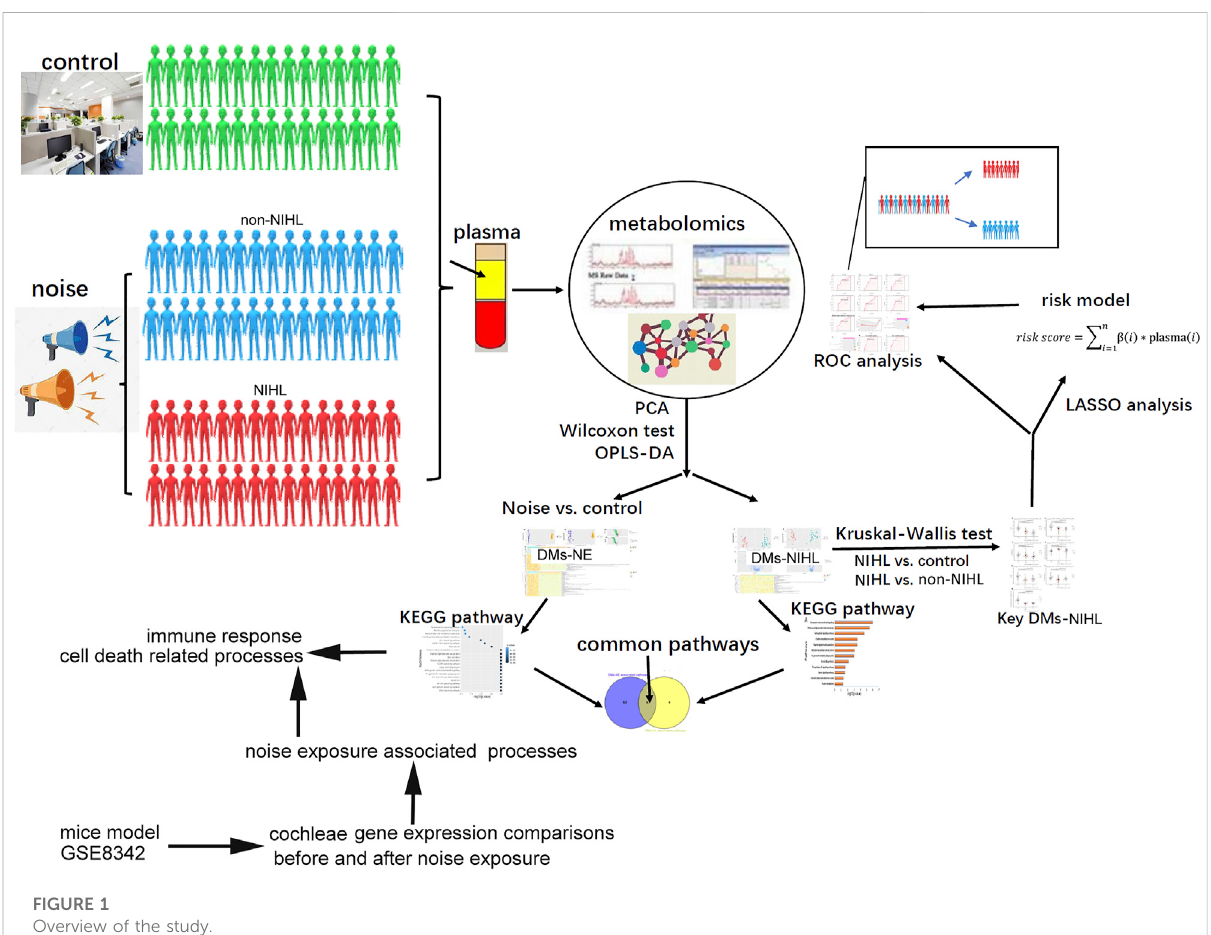
FIGURE 1 Overview of the